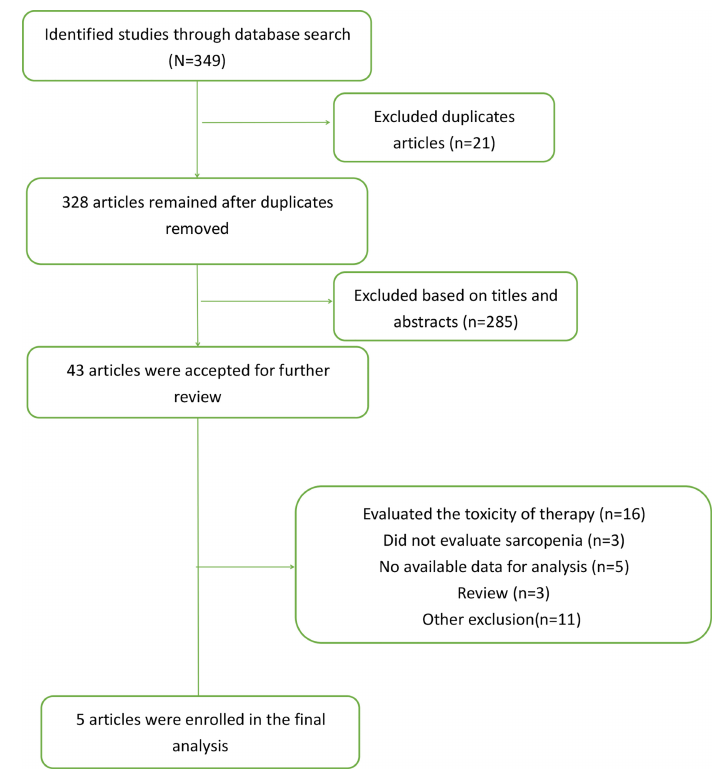
Figure 1 - Flow chart of search